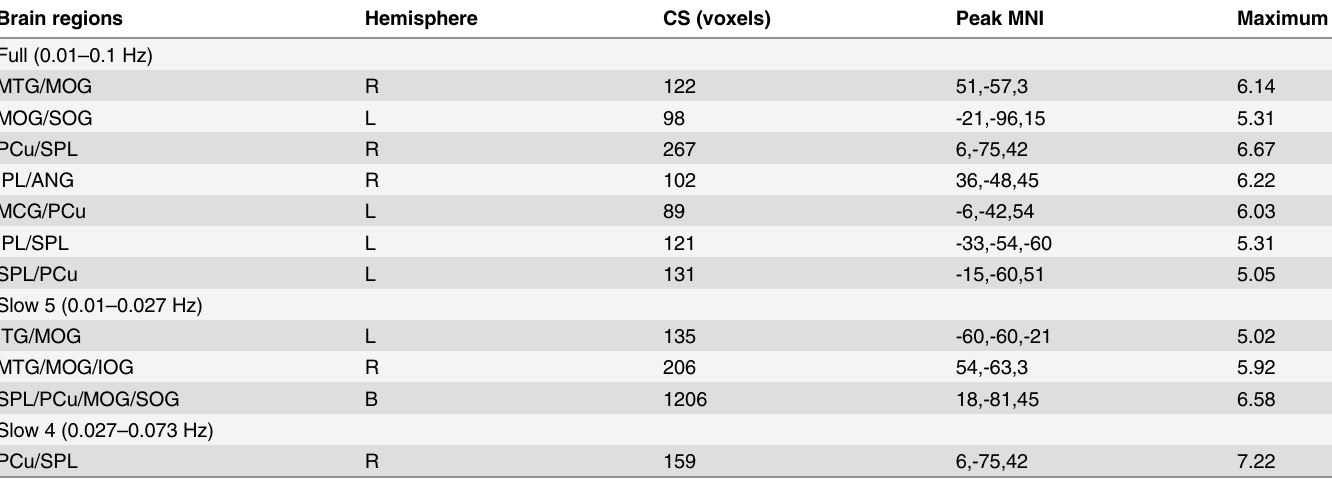
Table 2. Regions showing decreased ALFF in stroke patients versus normal controls.